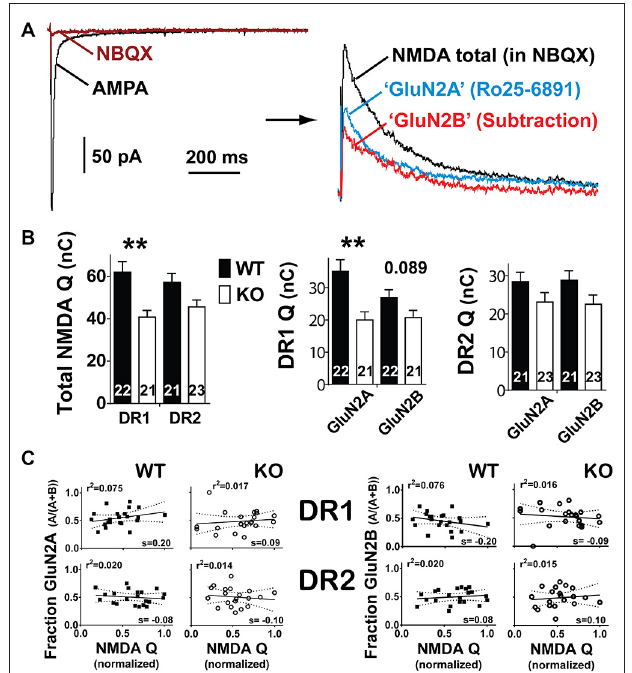
FIGURE 3 | Reduction in NMDAR currents is mainly due to a decrease in GluN2A currents. (A) AMPA receptor currents were blocked with the antagonist 5 µ M NBQX (left). Afterwards, baseline NMDAR currents were recorded at +40mV followed by the application of 0.5–1 µ M Ro25–6891 (a GluN2B antagonist, right). The remaining current (blue trace) is considered to be driven by NMDARs containing GluN2A subunits. To estimate the contribution of GluN2B subunits to the total NMDAR current, the GluN2A component was subtracted from the total. The difference (red trace) was considered to be driven by GluN2B. (B) Left panel. Integration of total NMDAR current confirmed the selective reduction in this conductance in the direct pathway. Middle and right panels. In the direct pathway, GluN2A was significantly reduced whereas GluN2B shows a trend towards reduction. Instead, in the indirect pathway neither conductance showed significant changes. ** p < 0.01. (C) Regression analysis of NMDAR currents (normalized) vs. the fraction of GluN2A (left) or the fraction GluN2B (right). NMDAR currents were normalized to the maximal peak current for their WT control group within the direct and indirect pathways. No significant correlation was found between the amplitude of the normalized NMDAR current and the fraction contributed by GluN2A or GluN2B currents in either